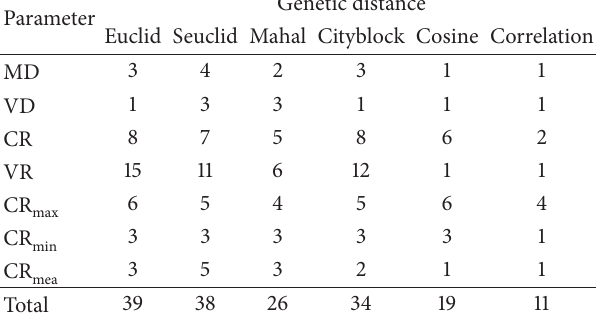
Table 1: The number of homogeneous populations of Tukey’s test ( 𝛼 = 0.05 ) of 7 evaluating parameters in each germplasm population from the sampling percentage of 10% to